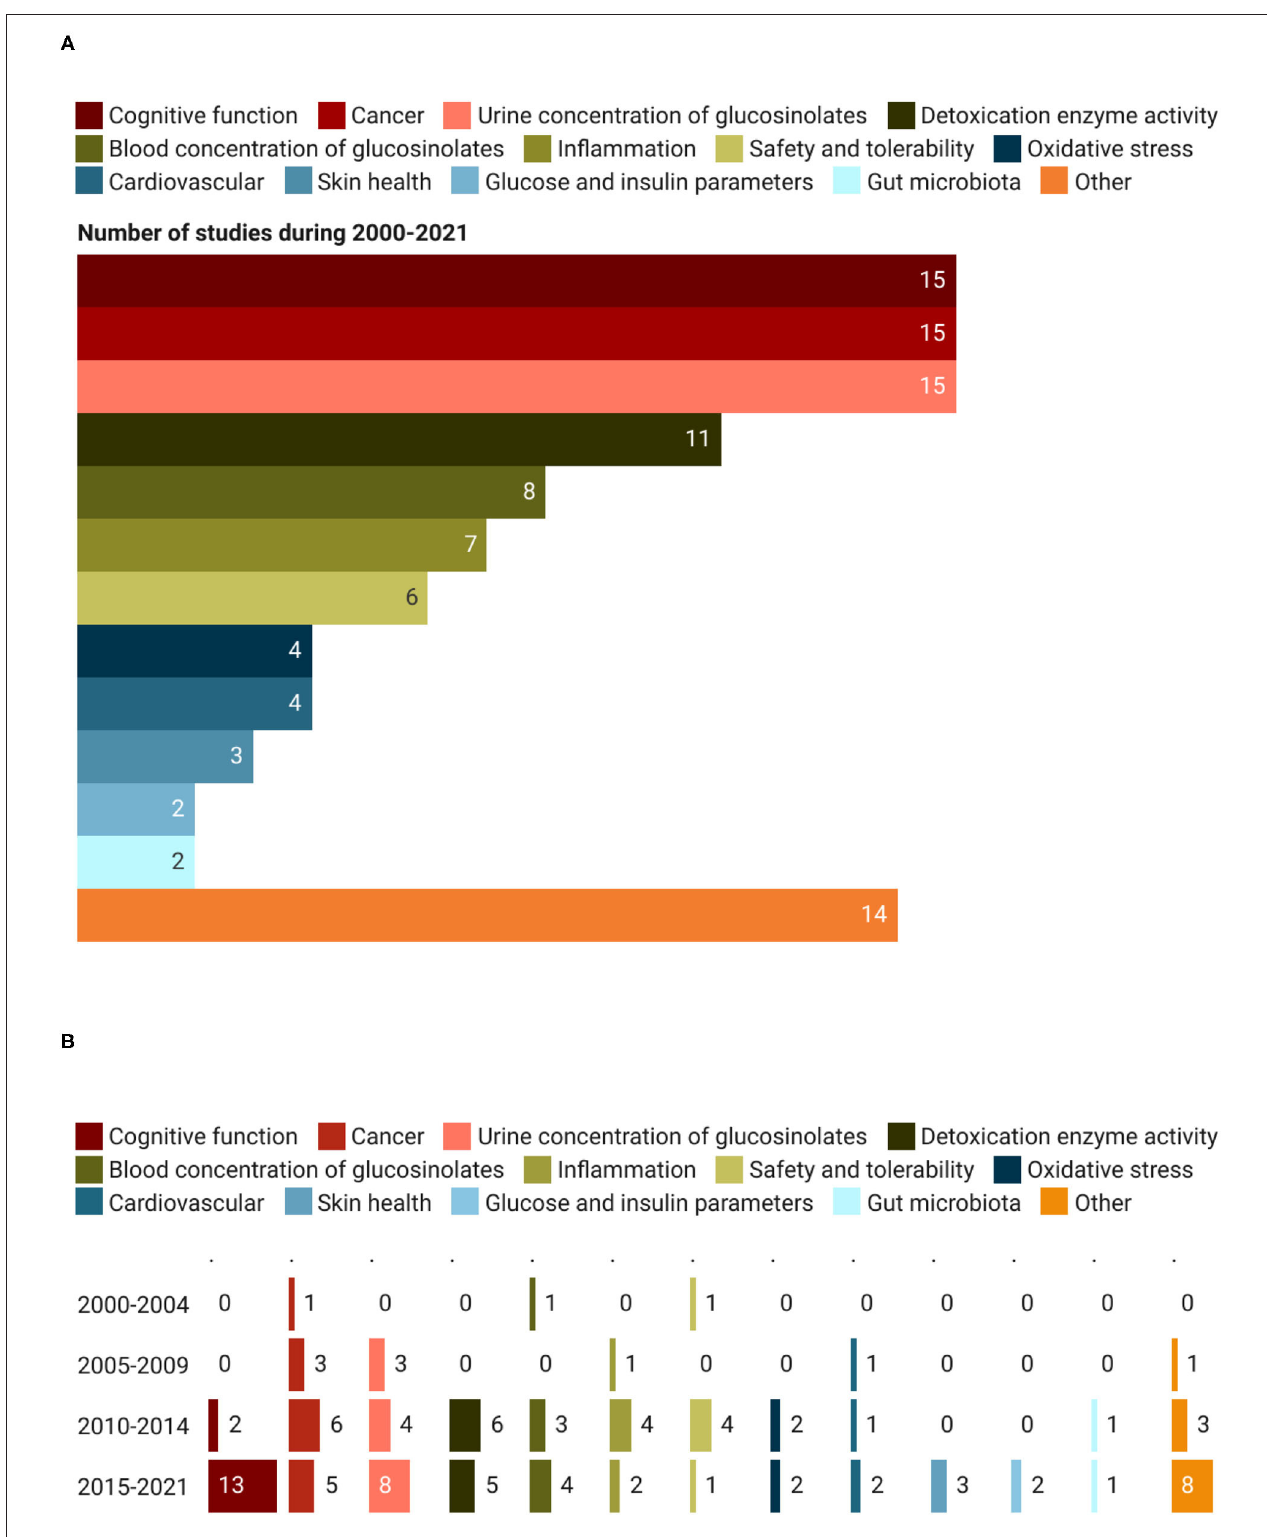
FIGURE 8 | Primary outcomes (A) and their trend (B) assessed during clinical trials on GSLs.